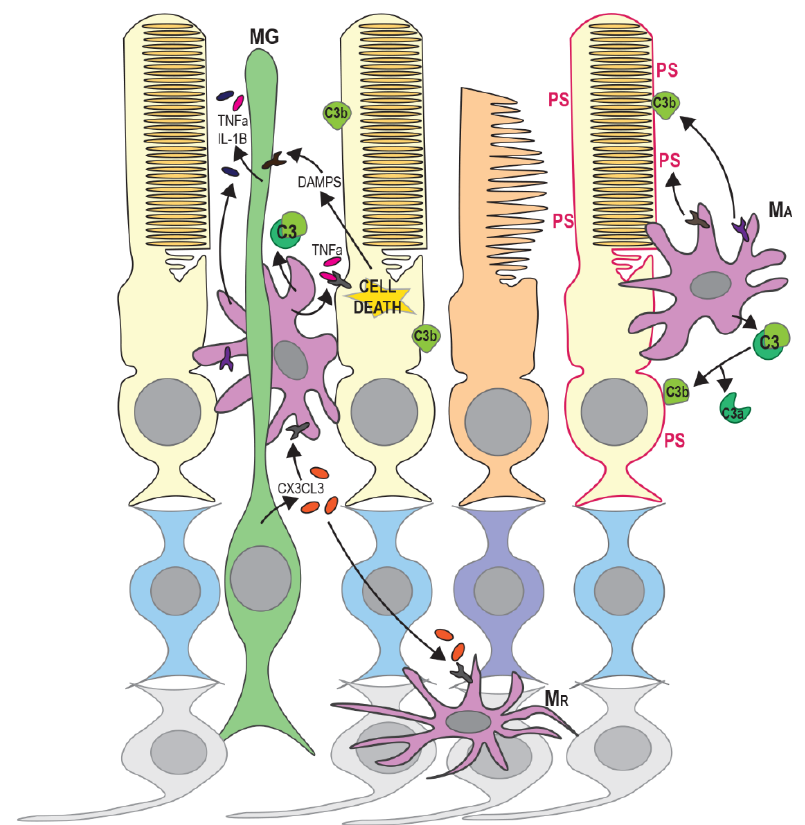
Figure 3. Microglia have an active role in photoreceptor death in RP. DAMPS released by apoptotic or necrotic photoreceptors trigger the release of inflammatory factors and cytokines from Müller glia (MG). Activated MG increase the expression and secretion of CX3CL3, leading to the activation of resting microglia (M R ). Activated microglia (M A ) secrete complement components including C3, which is cleaved to C3b on damaged or dying photoreceptors, marking these cells for phagocytosis. Stressed/damaged photoreceptors also expose phosphatidylserine (PS) on the outer surface of the cell membrane and this is also recognised by phagocytic receptors on activated microglia. The further release of inflammatory factors from M A and MG induces apoptotic or necroptotic cell death in nearby photoreceptors. These processes affect rods (yellow) more than cones (orange) in early disease stages.